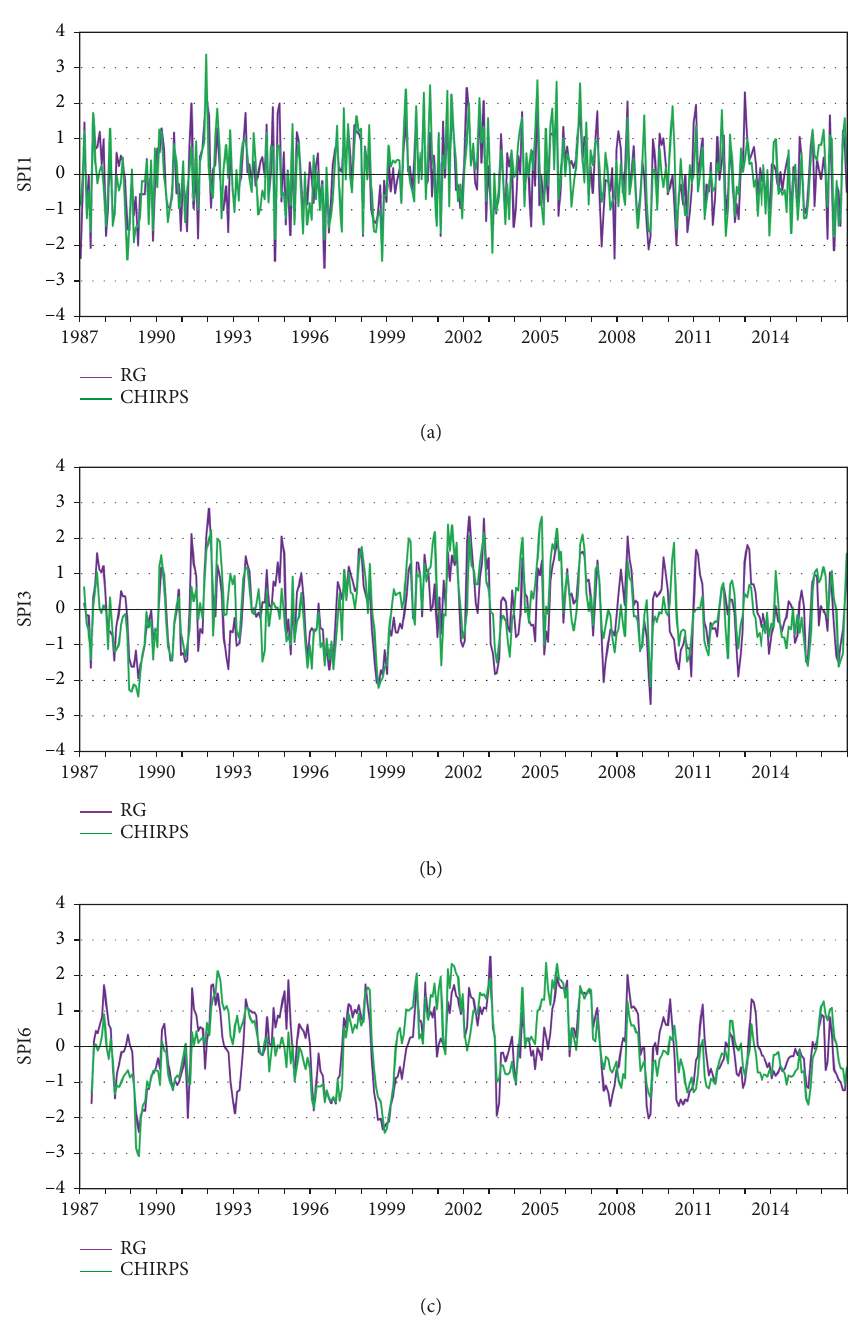
Figure 4: SPI time series for the CS region based on CHIRPS and rain gauges (RG) during 1987–2016: (a) SPI1, (b) SPI3, and (c)